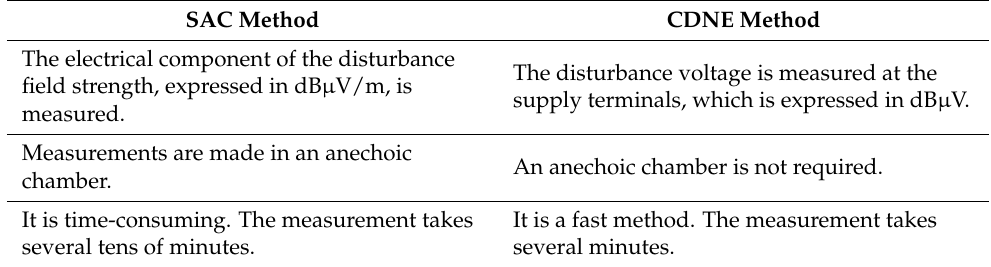
Table 3. Comparison of the SAC and CDNE